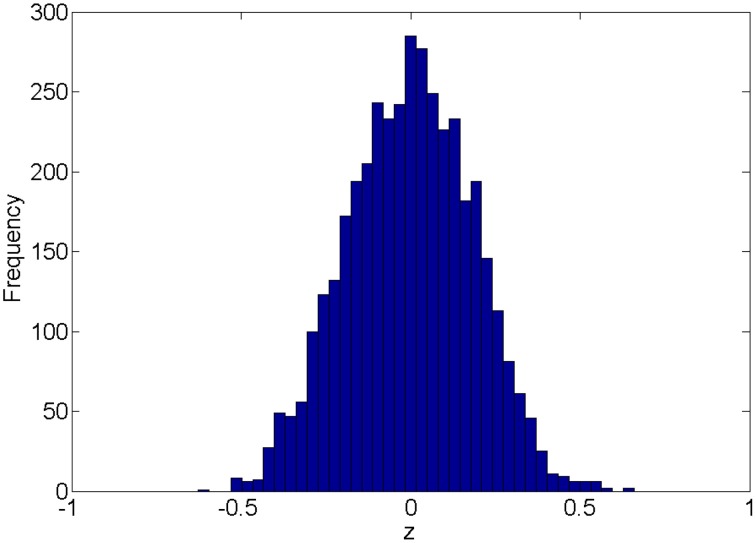
Empirical distribution of pairwise correlations between 90 random white noise vectors.